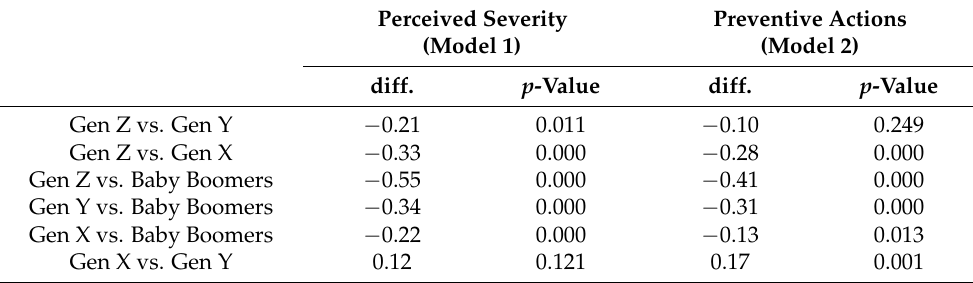
Table 4. Pairwise Comparisons of Gen X, Y, Z, and Baby Boomers.